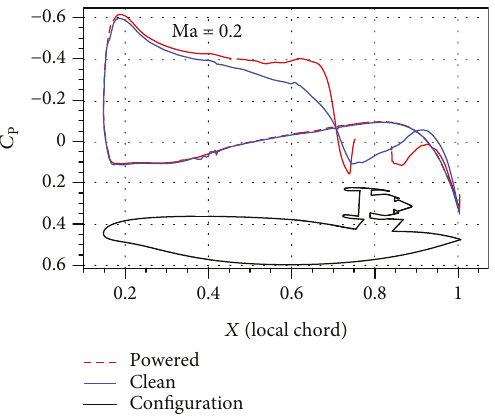
Figure 22: Upper surface pressure distribution airframe on the engine ’ s symmetrical plane at 9 ° (low